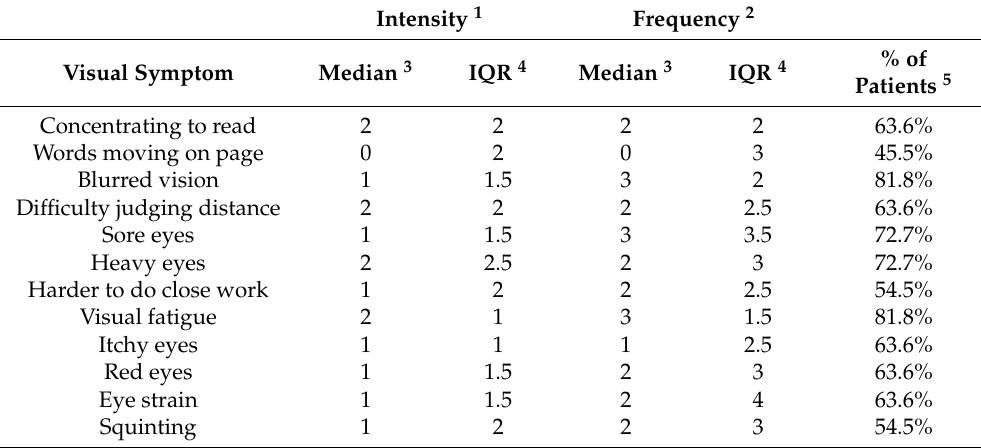
Table 1. Median, interquartile range, and percentage of patients reporting presence of each individual visual complaint.